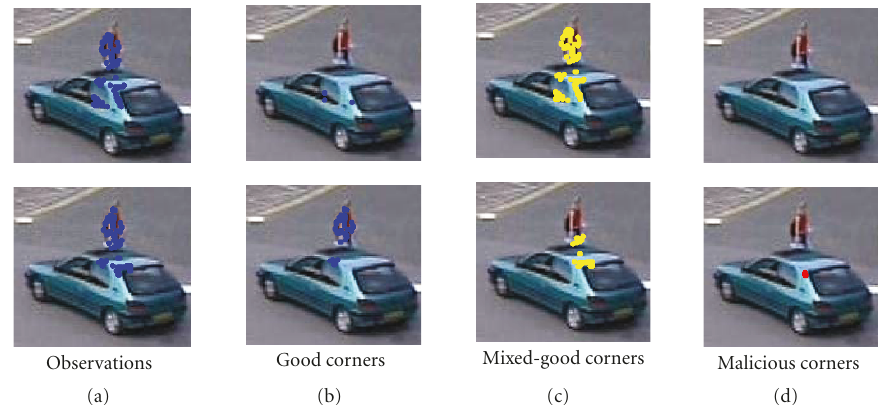
Figure 10: First step corners classification in Frame #570, columns from left to right: all observations: all the corners used to vote in the frame (blue), good corners (blue), mixed-good corners (yellow), and malicious corners (red). First row: updating the model during occlusion along with adding the unassociated corners to the model (corresponds to the second column of Figure 11). Second row: updating without adding the unassociated corners (corresponds to the third column of Figure 11). The first updating policy has not been able to classify precisely. There is no malicious corner using this policy (first row, last